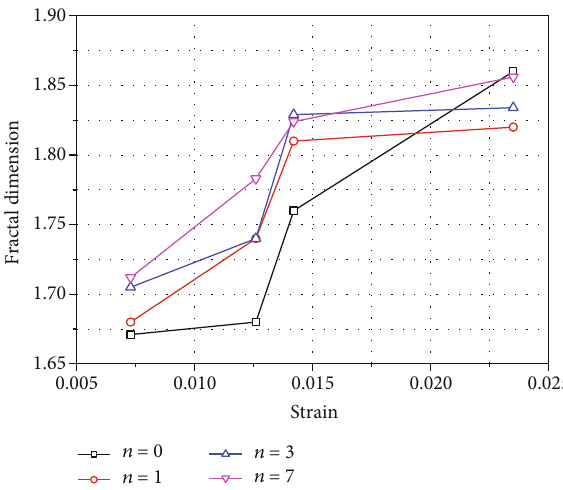
Figure 11: Rule of fractal dimension values at di ff erent bend